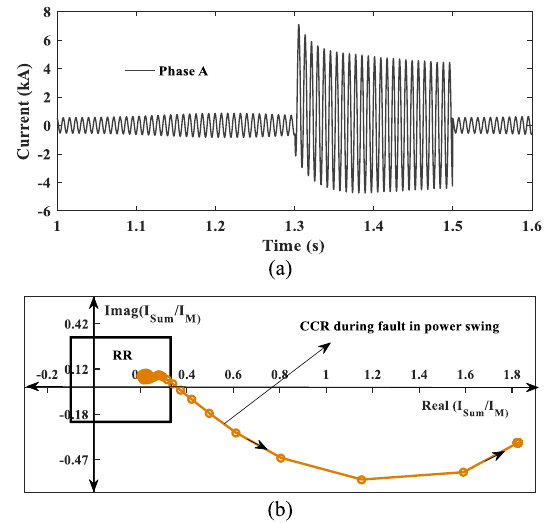
Fig. 10 CCR during faults in series compensated lines (before and after)